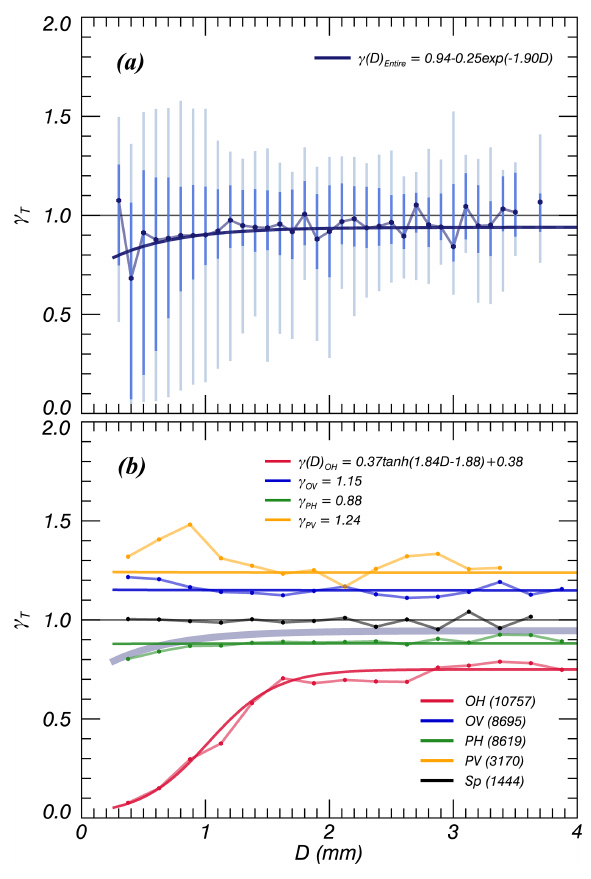
Figure 12. Same as Fig. 9 but for γ